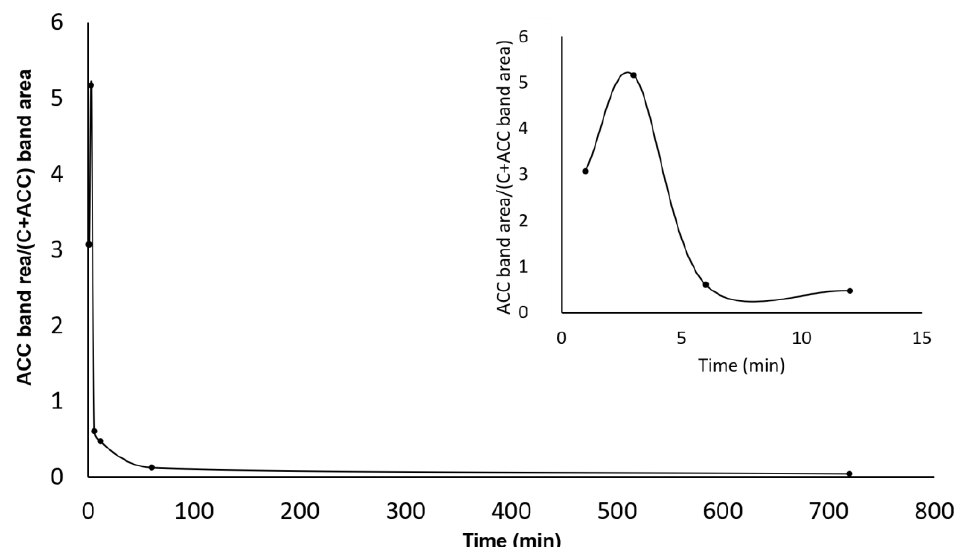
Figure 8. Percentage of individual bands of calcite versus time. Insert shows in detail the behavior in the first 12 min.